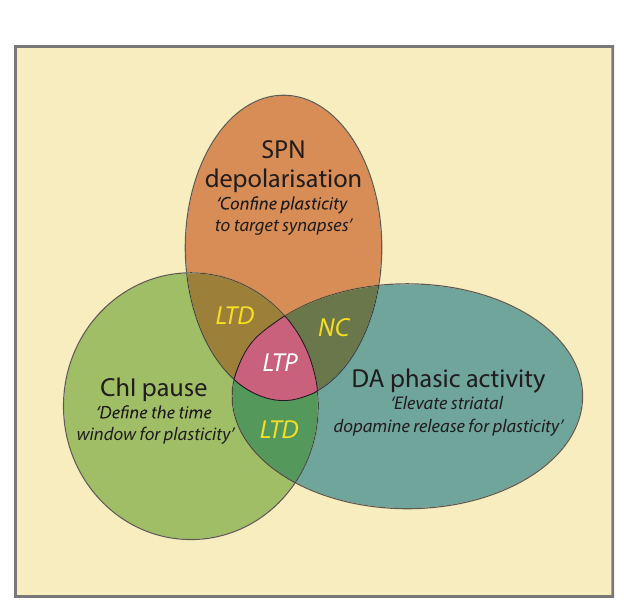
Fig. 4 A model of corticostriatal synaptic plasticity. Corticostriatal LTP (pink) is induced when SPNs are depolarised (brown) in a striatal area where a ChI pause response (green) is coincident with a phasic dopamine signal (blue). Other conditions will result in LTD or no change